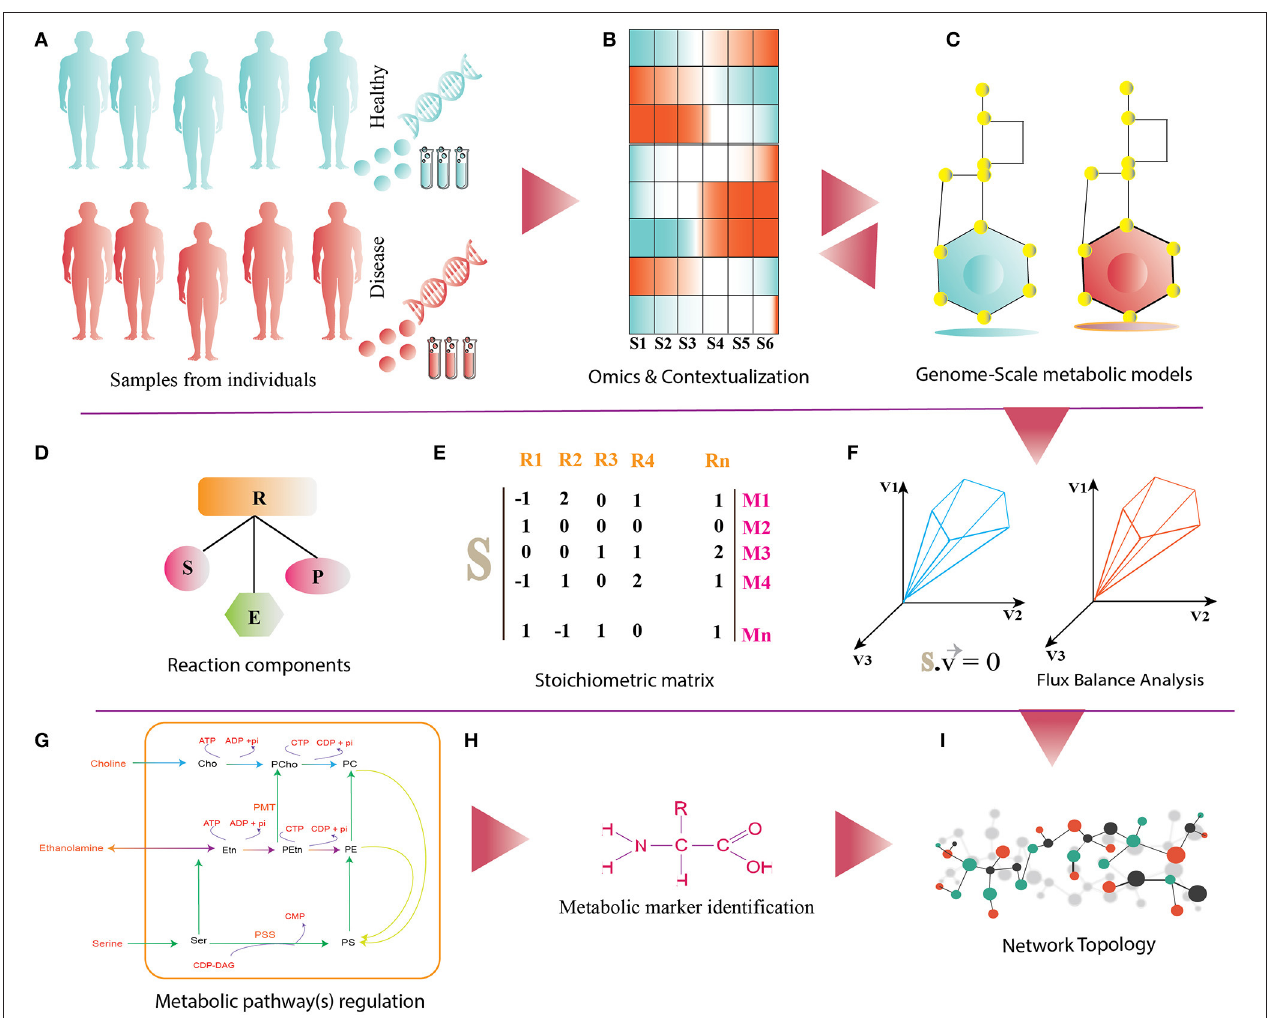
FIGURE 2 | (A) It shows disease and healthy individuals (controls) from which PBMCs samples are obtained for omics analysis. (B) Differential omics expression and analysis for contextualization. (C) Reconstruction and contextualization of condition specific genome-scale metabolic models. (D) Reaction components (R) of Genome-Scale metabolic models: S, substrates; E, enzymes; P, products. (E) Stoichiometric matrix (S) of M n metabolites and R n reactions, directionality of each metabolites consumed ( − 1) or produced ( + 1) or not involved in the reaction (0). (F) Flux-Balance Analysis (FBA) for model simulation, optimization and estimation of flux (v) phenotype at the steady state. (G–I) The panel shows functionalities of genome-scale metabolic models such as regulations of metabolic pathway, metabolic marker identification and identification of differential